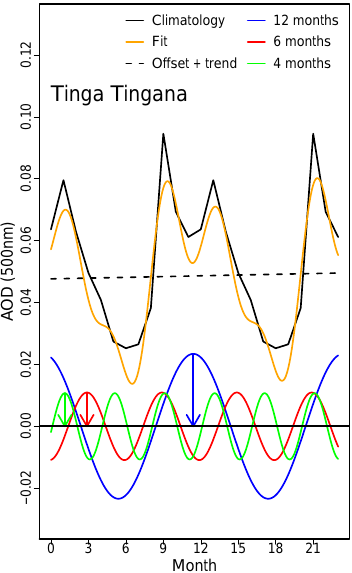
Figure 5. Illustration of the Fourier decomposition of the periodic component of the aerosol optical depth at Tinga Tingana. The fit- ted curve (orange) results from the addition of the offset plus lin- ear trend (dashed line) to the three sinusoids corresponding to pe- riods of 12 months (blue), 6 months (red) and 4 months (green). The arrowed phase times of the three sinusoids were 11.4, 2.9 and 1.1 months respectively. The phase times are referenced to the first December in each time series, denoted as month zero in this plot. The observed climatology is shown as the black solid line. The lin- ear trend apparent in the dashed line is not significant at the 5% level (see Table